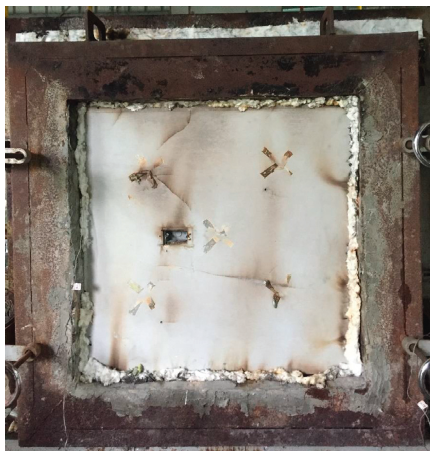
Figure 19: The result of the specimen after the 60min standard fire test in Test